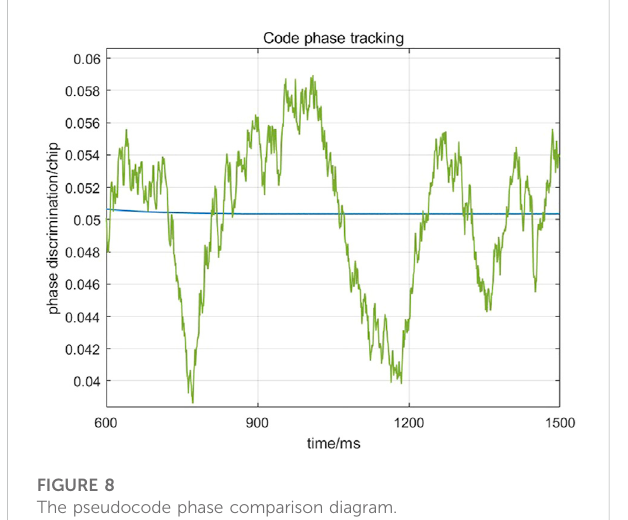
FIGURE 8 The pseudocode phase comparison diagram.